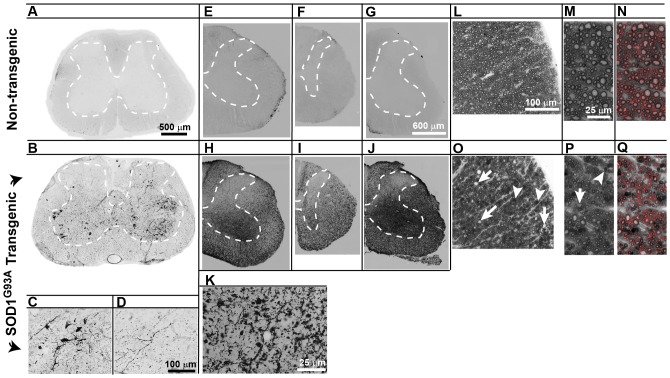
Significant degeneration of descending medium-, and large-size myelinated axons in lumbar segments in endstage SODG93A rats.Using the Gallyas silver impregnation technique, degenerating neurons were detected mostly within the ventral horn, although reactive cells were often noted in upper lamina (A- non-transgenic, B- SOD1G93Aendstage). Closer examination shows fragmented cells and fibers not only within the grey matter, but also in the adjacent white matter (C, D). The de Olmos modified cupric-silver stain was used to help detect degenerating axons and dendrites; non-transgenic tissue showed no appreciable staining (E – cervical, F-thoracic, G – lumbar), while SOD1G93A tissue reacted intensely, not only in the ventral horns but throughout the gray matter, sparing only lamina I–III (H–J). Closer examination of the white matter showed argyrophilic punctate structures corresponding to silver deposits in disintegrated axons (K). Semithin (1 µm) plastic-embedded tissue sections were used to quantify changes in the axonal population in the lateral and ventral columns. While clearly-delineated axons of varied caliber were readily-outlined by the osmium-stained myelin in non-transgenic animals (L–N), tissue from endstage SOD1G93A animals had an easily recognizable reduction of large caliber myelinated axons (O–Q). Lumbar white matter in SOD1G93A endstage animals also contained numerous vacuoles (O, P, arrows) and frequent osmium-dense deposits (O, P, arrowheads). Scale bar: 500 µm (A, B), 100 µm (C, D), 600 µm (E–J), 25 µm (K), 100 µm(L, O), 25 µm (M, N, P, Q).